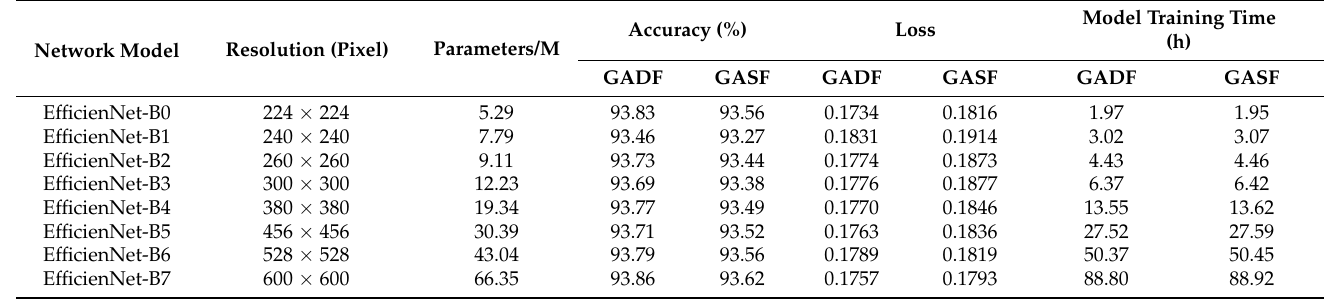
Table 2. EfficientNetB0-B7 network comparison experiment